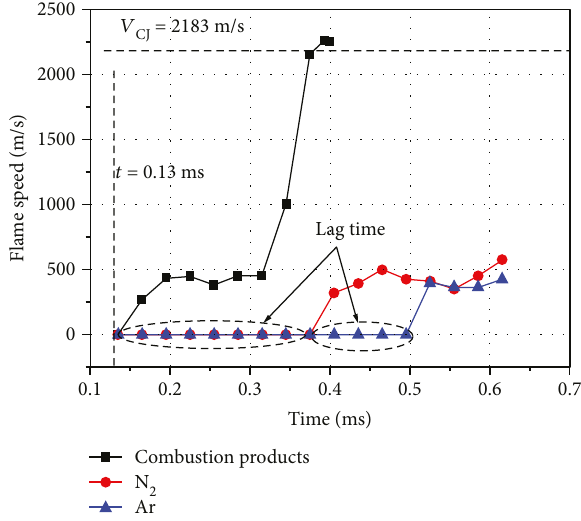
Figure 17: Variation of fl ame propagation speed with